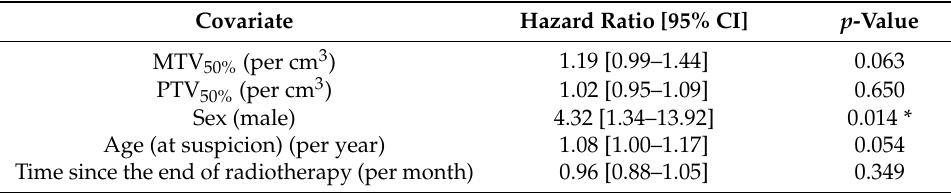
Table 4. Multivariate survival analysis in patients with relapsed lung